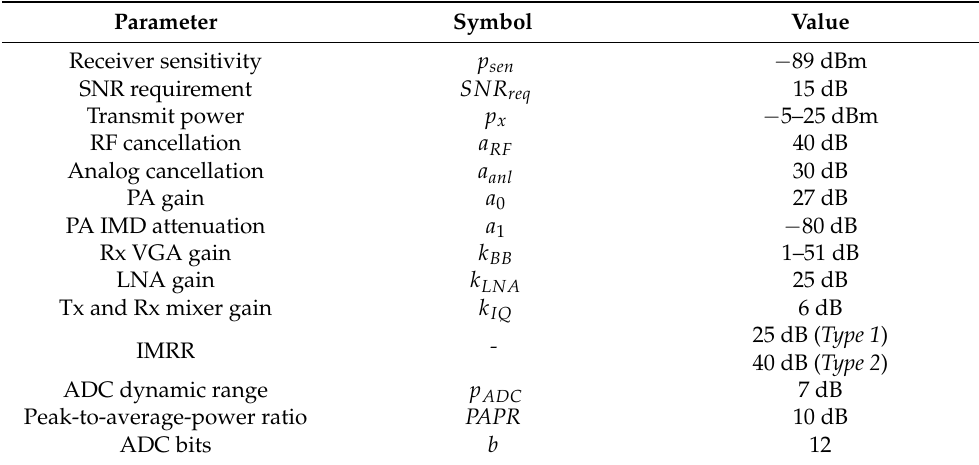
Table 2. Typical parameters for FD transceivers and their notations.